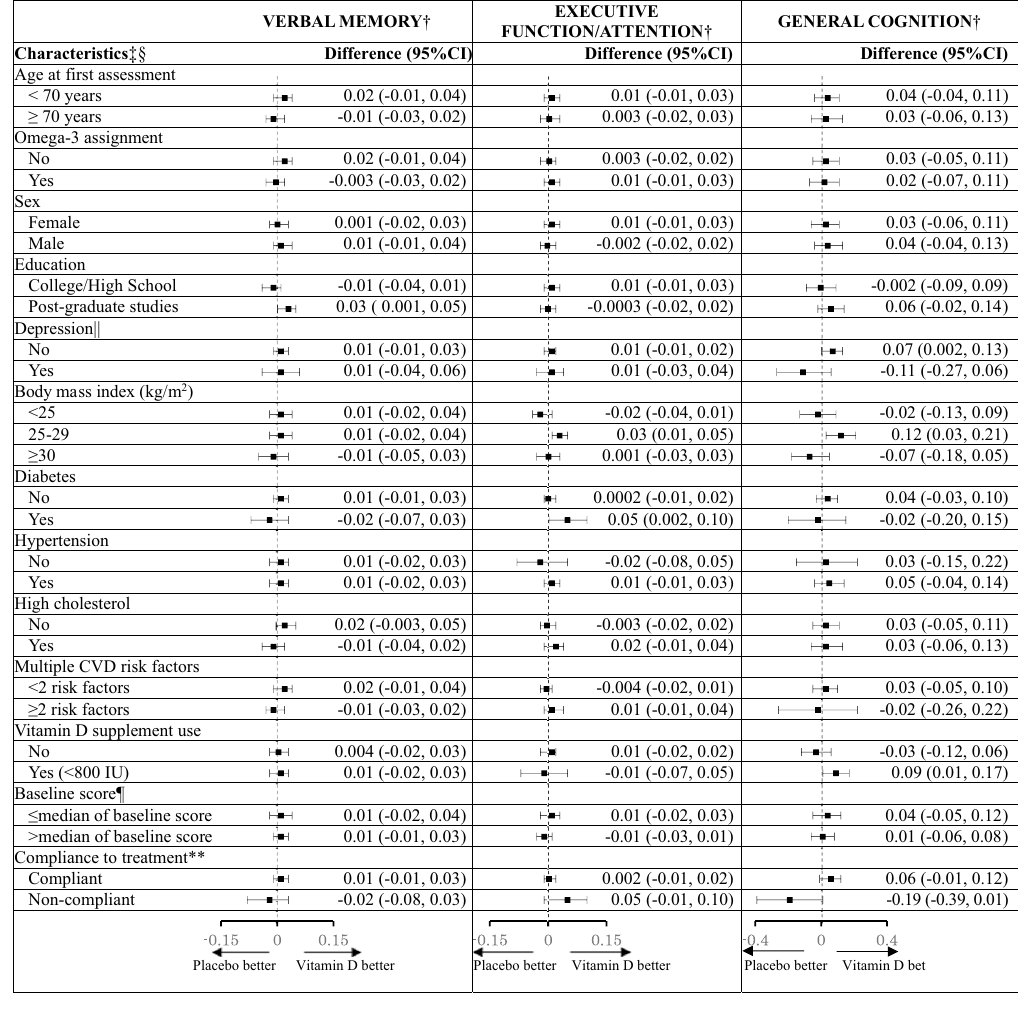
Table 6. Pooled results across VITAL-Cog and CTSC-Cog for mean difference in annual rate for the secondary outcomes for vitamin D-Placebo: effect modification by risk factors for cognitive decline. 3MS Modified Mini- Mental Status exam; CI confidence interval; CTSC-Cog subset that received in-person interviews at the Harvard Clinical and Translational Science Collaborative center for VITAL in Boston, MA; TICS Telephone Interview of Cognitive Status; VITAL-Cog subset that received telephone interviews in VITAL. From multivariable-adjusted linear mixed models of cognitive performance (model 2) as described in footnote in Table 3. a For definitions of the verbal memory and executive function scores for the two populations, see footnotes for Table 2. For general cognition, due to the differences in scale between the TICS (0–41) and 3MS (range 0–100), for pooling purposes, the 3MS scores were multiplied by 0.41 for conversion to the same scale as the TICS scores. b Interaction terms across the two substudies were pooled using Dersimonian and Laird fixed-effects method for meta-analysis. For a few interactions where there was significant heterogeneity (p < 0.05) for the estimate across the two substudies, random effects were incorporated into the meta-analysis. Among these non-pre-specified modifiers for secondary outcomes, none of the pooled p-interactions were significant at Bonferroni-adjusted p-value of 0.0038 (= 0.05/13 subgroup analyses), except for three nominally significant pooled p-interactions for education for verbal memory (p = 0.04), diabetes for executive function/attention (p = 0.04); compliance for general cognition (p = 0.01). c Stratum-specific estimates were pooled using Dersimonian and Laird fixed- effects method for meta-analysis. For a few strata where there was significant heterogeneity (p < 0.05) for the estimate across the two substudies, random effects were incorporated into the meta-analysis. For reference, the fixed effects pooled estimate for executive function/attention is 0.002 (95% CI − 0.02, 0.02) for those without hypertension; 0.01 (95% CI − 0.01, 0.03) for those taking Vitamin D supplements (< 800 IU) outside of the trial; and the pooled estimate for general cognition is − 0.001 (95% CI − 0.08, 0.08) for those without hypertension and 0.03 (95% CI − 0.06, 0.13) for those with multiple CVD risk factors. d For the definition of depression, see footnote in Table 1. e For the verbal memory score, the median was -0.02 standard units in VITAL-Cog and 0.02 in the CTSC-Cog; for the executive memory/attention score, the median was 0.04 in VITAL-Cog and 0.02 in the CTSC-Cog; for TICS, the median was 34 in VITAL-Cog and for the 3MS in CTSC-Cog, the median was 96 (equivalent to 39 on the transformed variable to have the same range as the TICS). f Compliance is defined as taking ≥ 2/3rd of pills on all of the follow-up questionnaires between the first and the second cognitive assessment and not initiating out-of-study fish oil